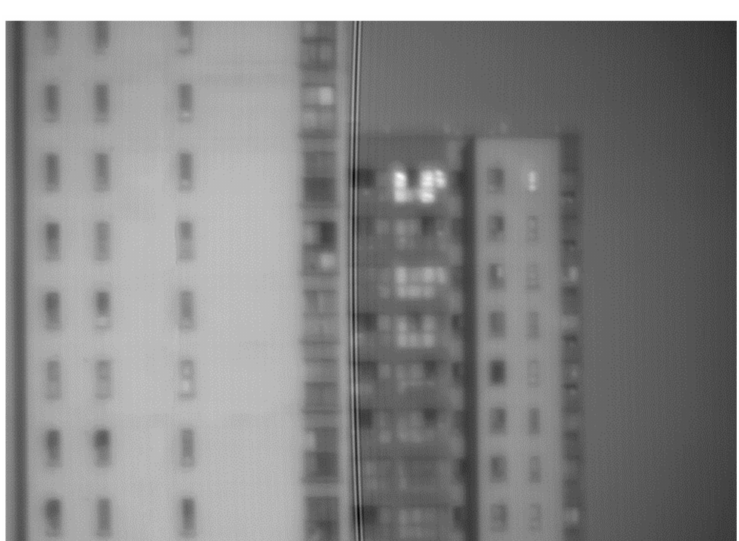
Figure 7. The SBFTIS prototype.